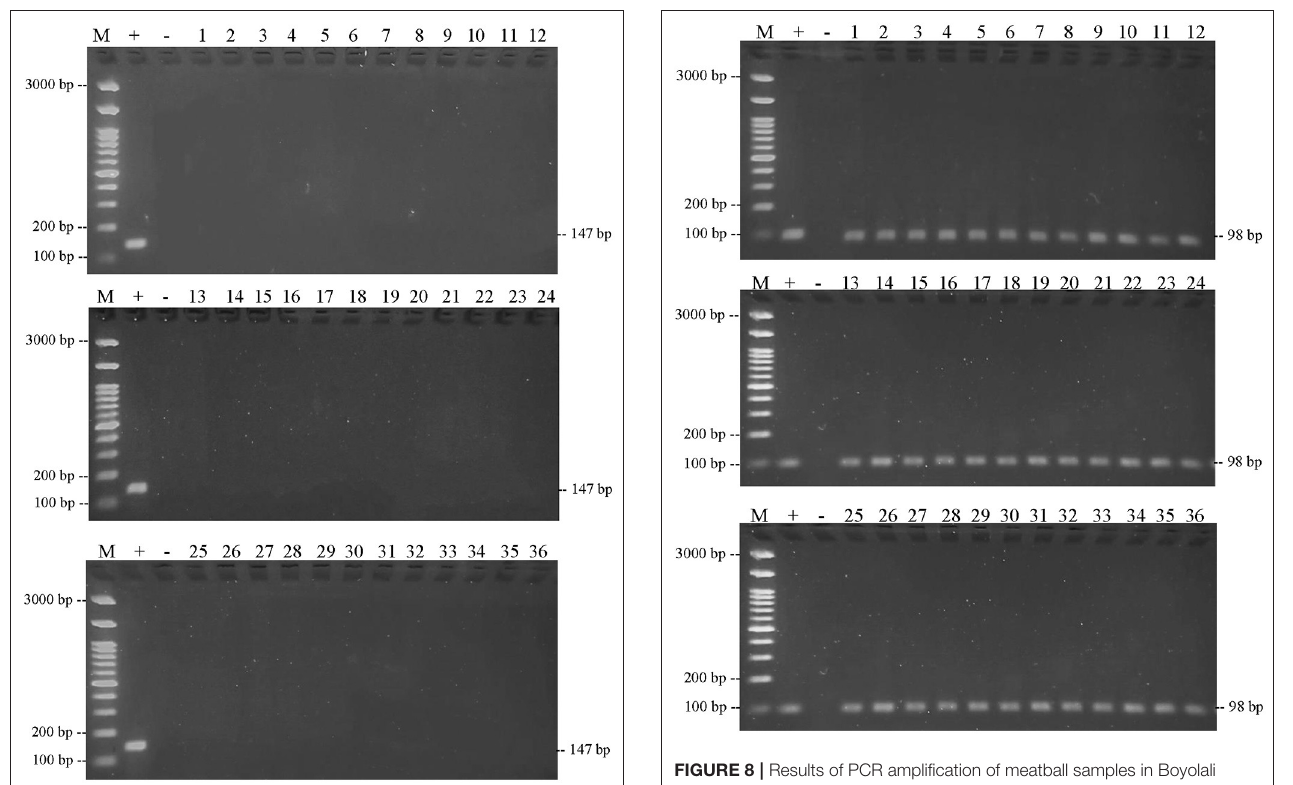
FIGURE 8 | Results of PCR amplification of meatball samples in Boyolali Regency with bovine primers and electrophoresis on 2% agarose gels. (M) DNA marker 100 bp; ( + ) positive control meatballs; (–) negative control (no template control); samples were coded with numbers